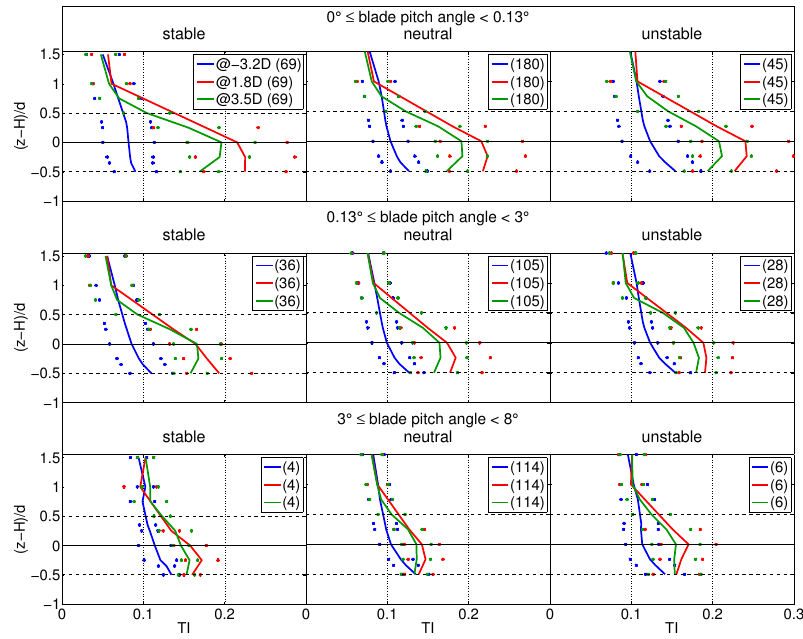
Figure 7. Mean profiles of TI filtered for pitch angles between 0 ◦ and 0.13 ◦ (top), 0.13 ◦ and 3 ◦ (center) and 3 ◦ and 8 ◦ (bottom), wind directions between 217 ◦ and 237 ◦ and different stability classes. Dots indicate the standard deviation at each measurement altitude. The legend includes the number of averaged